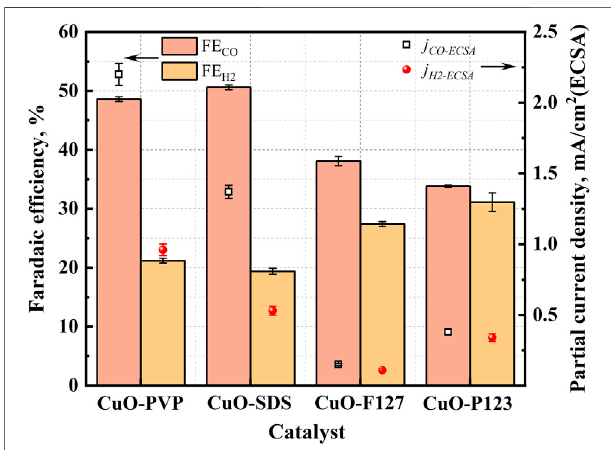
FIGURE 5 | Faradaic ef fi ciencies of CO and H 2 and partial current densities normalized to ECSA for the CuO nanostructures tested at − 0.93 V vs.